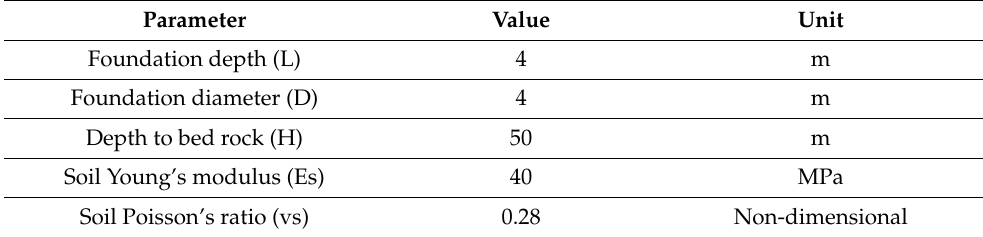
Table 4. Main input parameters of the example (Data from Jonkman et al. [39]; Alati et al. [40]). Parameter Value Unit Height of the jacket (h J ) 70 m Jacket bottom width (L bottom ) 12 m Jacket top width (L top ) 9.5 m Area of jacket leg (A C ) 0.1281 m 2 Distributed mass of the jacket including diagonals (m J ) 8150 kg/m Tower height (h T ) 70 m Bottom diameter of the tower (D bottom ) 5.6 m Top diameter of the tower (D top ) 4.0 m Distributed mass of the tower (m T ) 3730 kg/m Mass of Rotor-Nacelle Assembly (M RNA ) 350 tons Mass of transition piece (M TP ) 666 tons